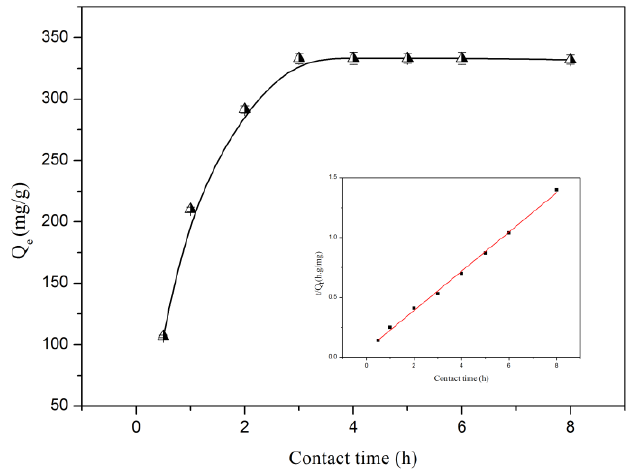
Figure 8. Kinetic adsorption results of Pb(II) on CLNPs. The inset shows the fitting results of the pseudo-second-order model for Pb(II) adsorption (CLNP dosage = 15 mg/50 mL, C 0 = 100 mg/L, temperature = 30 °C, pH = 6.03).